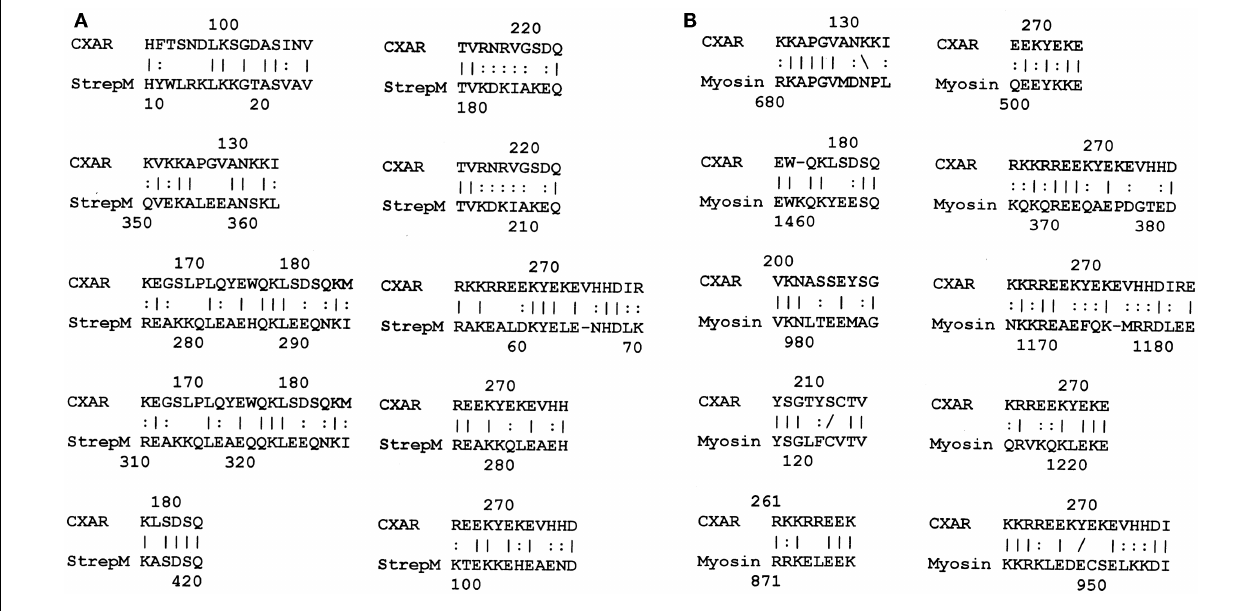
FIGURE 5 | (A) Results of LALIGN similarity search comparing human coxsackie and adenovirus receptor (CAR) (P78310) to group A streptococcal M protein (P02977); and (B) results of LALIGN similarity search comparing human coxsackie and adenovirus receptor (CAR) (P78310) to human cardiac myosin (P13533).